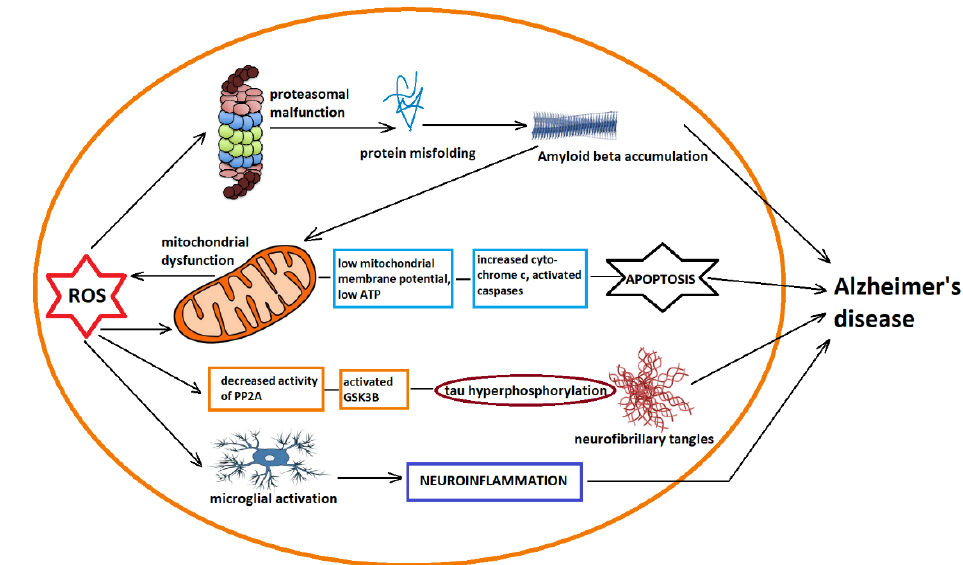
Figure 3. A complex relationship exists between oxidative stress which leads to mitochondrial dysfunction, that compromises mitochondrial bioenergetics and further increases oxidative stress. ROS also lead to protein misfolding and impair proteasomal function, causing accumulation of misfolded proteins and A β , which augments mitochondrial dysfunction. Through impaired enzymatic activity, various signaling pathways are altered, causing tau hyperphosphorylation. In addition, ROS activate microglia and neuroinflammation that further augments oxidative stress in AD.